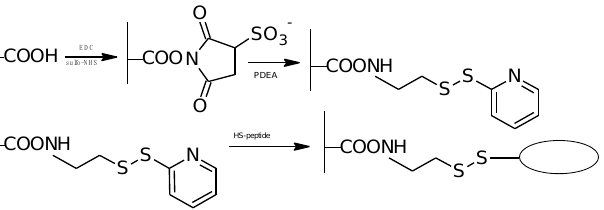
Figure 20. Synthesis of alginate-peptide conjugate by alginate-S-S-y intermediate.